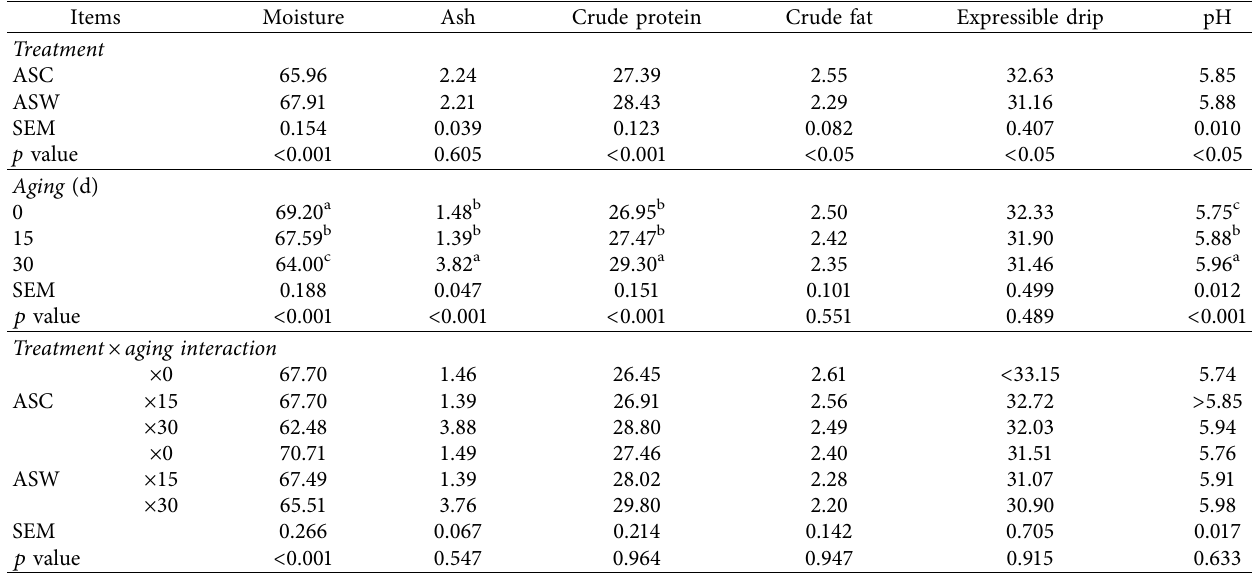
Table 3: Proximate analysis (%), pH, and expressible drip (%) of dry aged, sous vide-cooked pork loin from pigs fed a whey powder- supplemented diet.